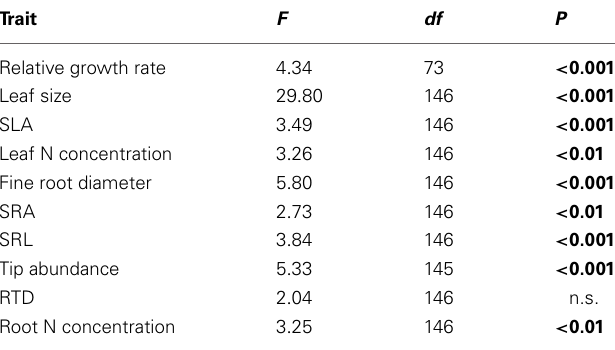
Table 3 | Results of ANOVA on leaf and root trait differences between the eight